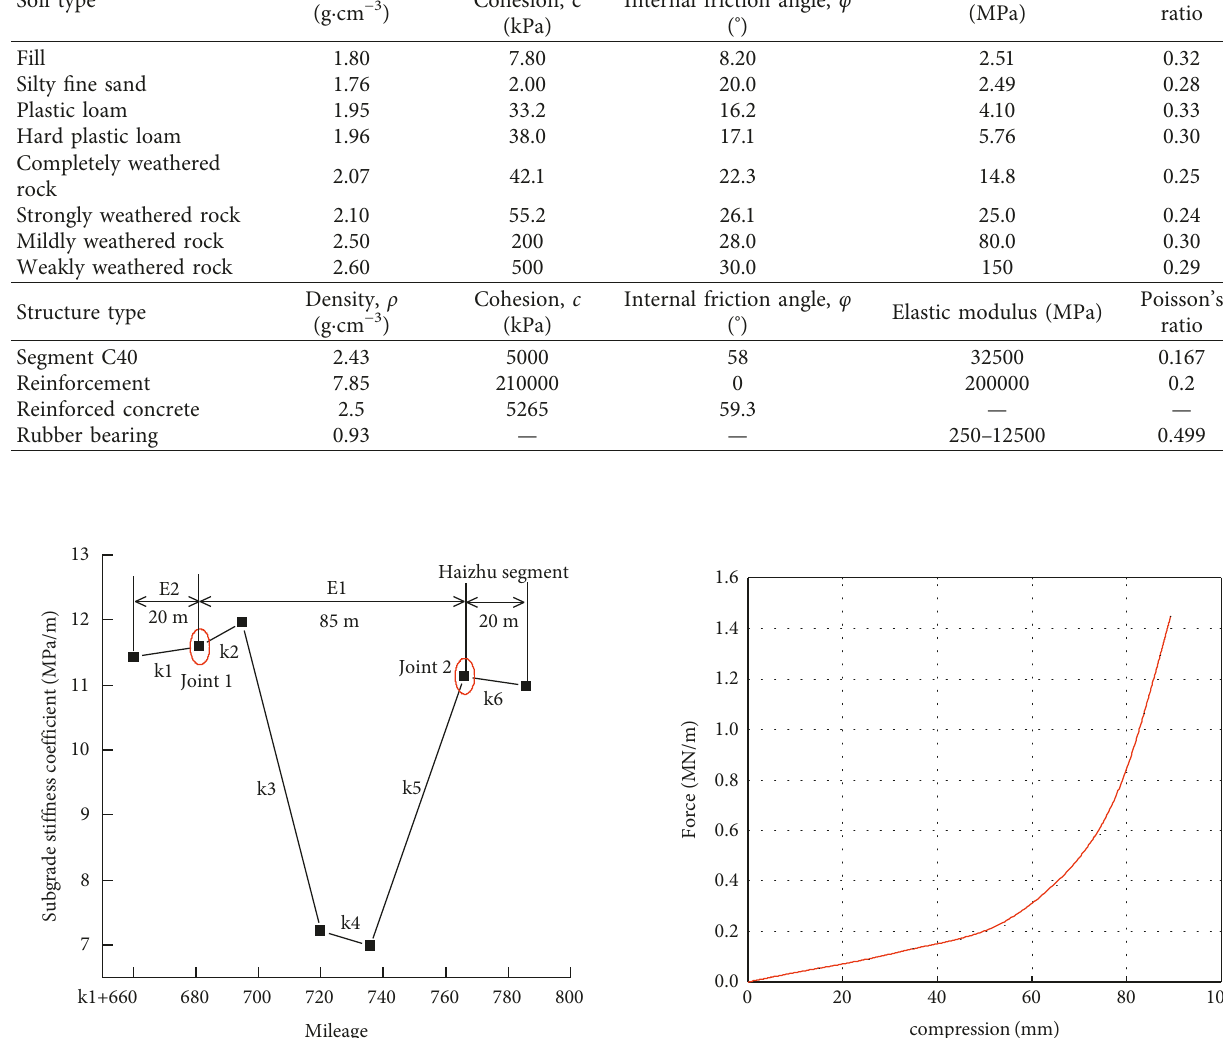
Figure 2: The subgrade stiffness coefficient. Figure 3: The load–displacement relationship of the GINA